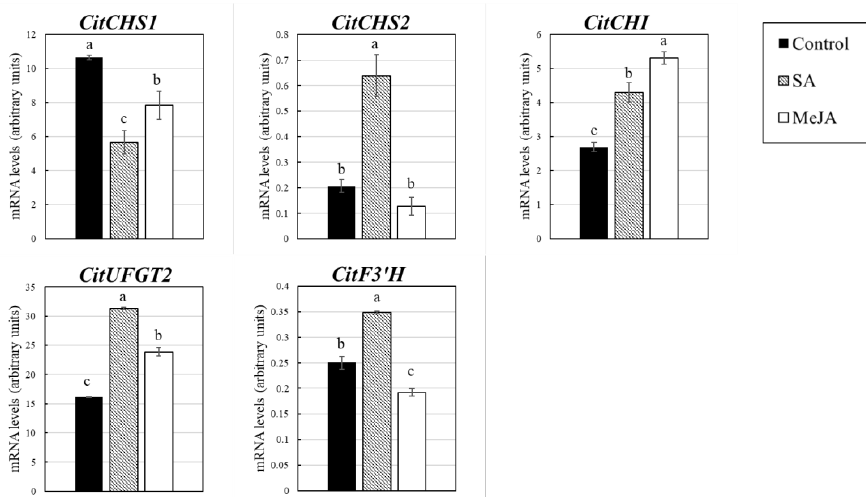
Figure 3 . Effect of salicylic acid (SA) and methyl jasmonate (MeJA) treatments on the expression of flavonoid metabolism related genes in the juice sacs of Satsuma mandarin in vitro. The mRNA levels were analyzed by TaqMan real-time RT-PCR, and the expression of 18S ribosomal RNA (rRNA) was used as a control to normalize the raw data. Columns and bars represent the means and SE ( n = 3), respectively. Different letters indicate significant differences at the 5% level by Tukey’s HSD test.